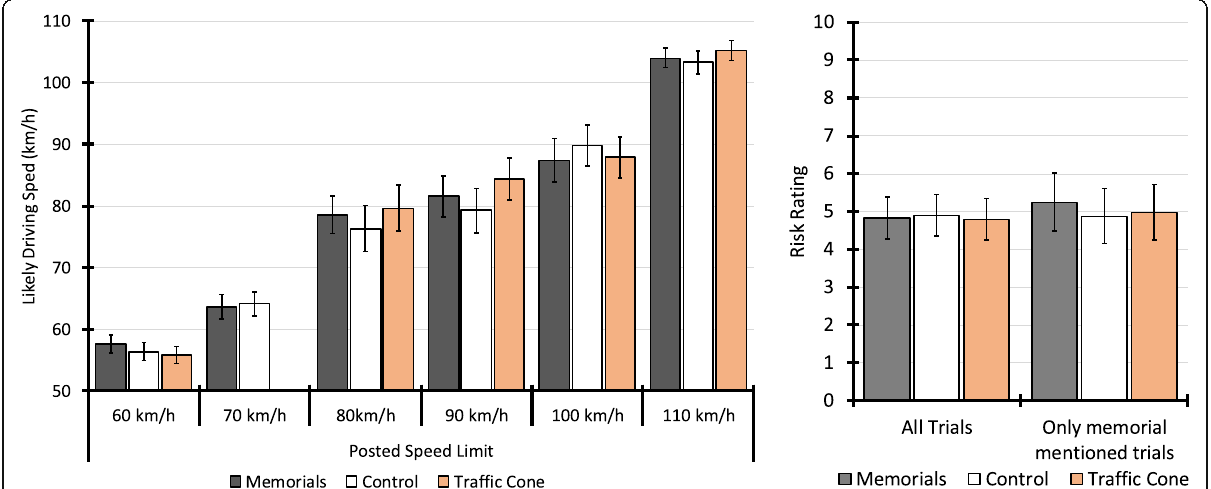
Fig. 4 Participants ’ self-nominated likely travel speeds (left panel) and risk ratings (right panel) by experimental condition. Error bars represent 95% confidence intervals. Note: there was only one clip with a 70 km/h official limit for the memorials and control conditions, and none for the traffic-cone condition as the road with the most similar road in terms of features had a 60 km/h limit